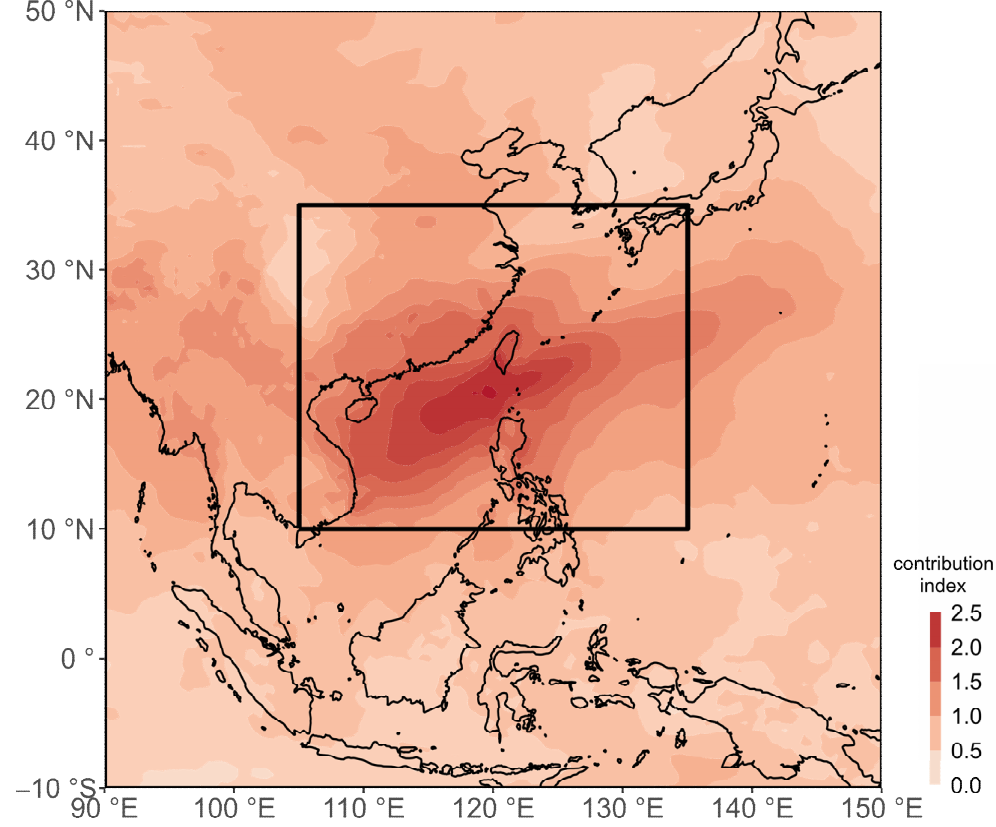
Figure 5. The composite of contribution index (CI). CI is obtained from the absolute values of correlation coefficients and the percentage of total explained variances of the leading 45 PCs for the selected CFSR variables.